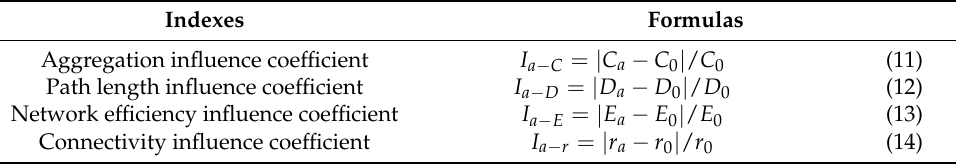
Table 4. Global impact indexes.